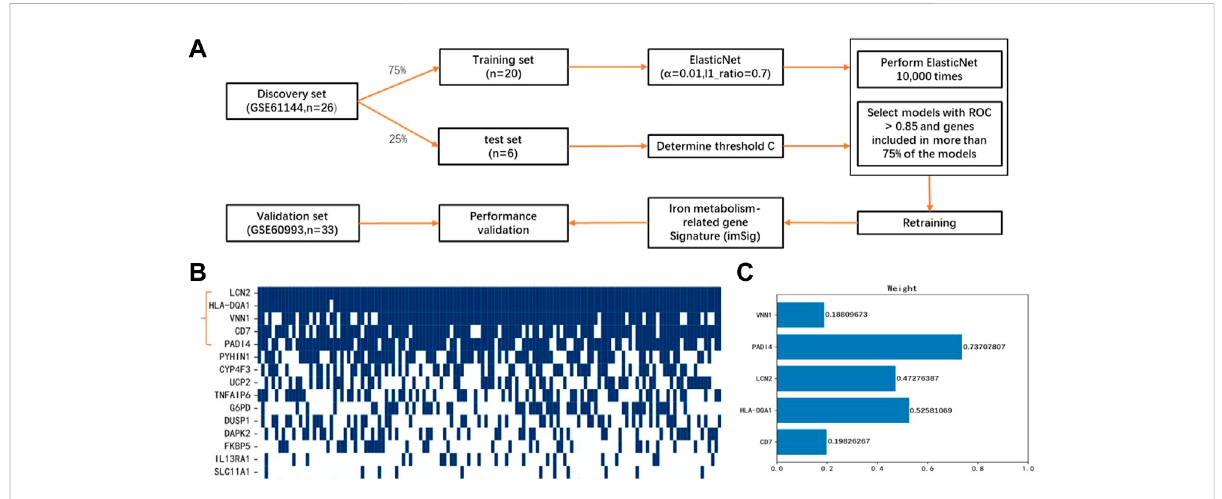
FIGURE 3 ConstructionofmiSigmodel (A) Work fl owofthisstudy. (B) Featuregeneselectionusing10,000randommodels.Bluegridindicatesthegeneis includedinapowerful modelwithROC > 0.85,whilewhitegridrepresentsthegeneisnotincludedinanypowerfulmodel. (C) Weightofgenesinthe miSig